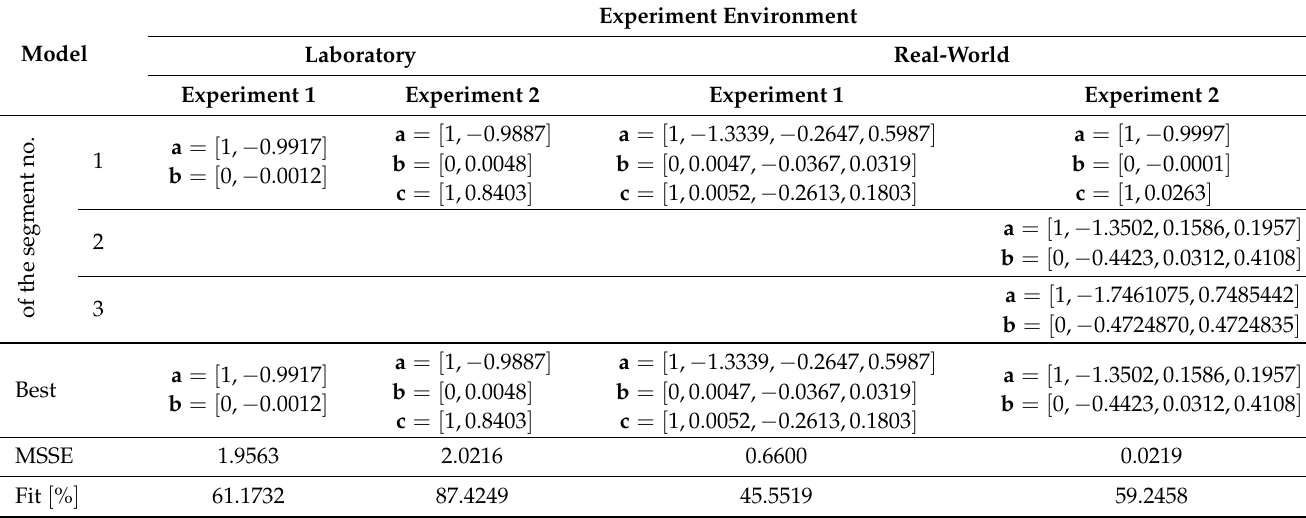
Table 4. Numerical results of the identification procedure obtained from the four